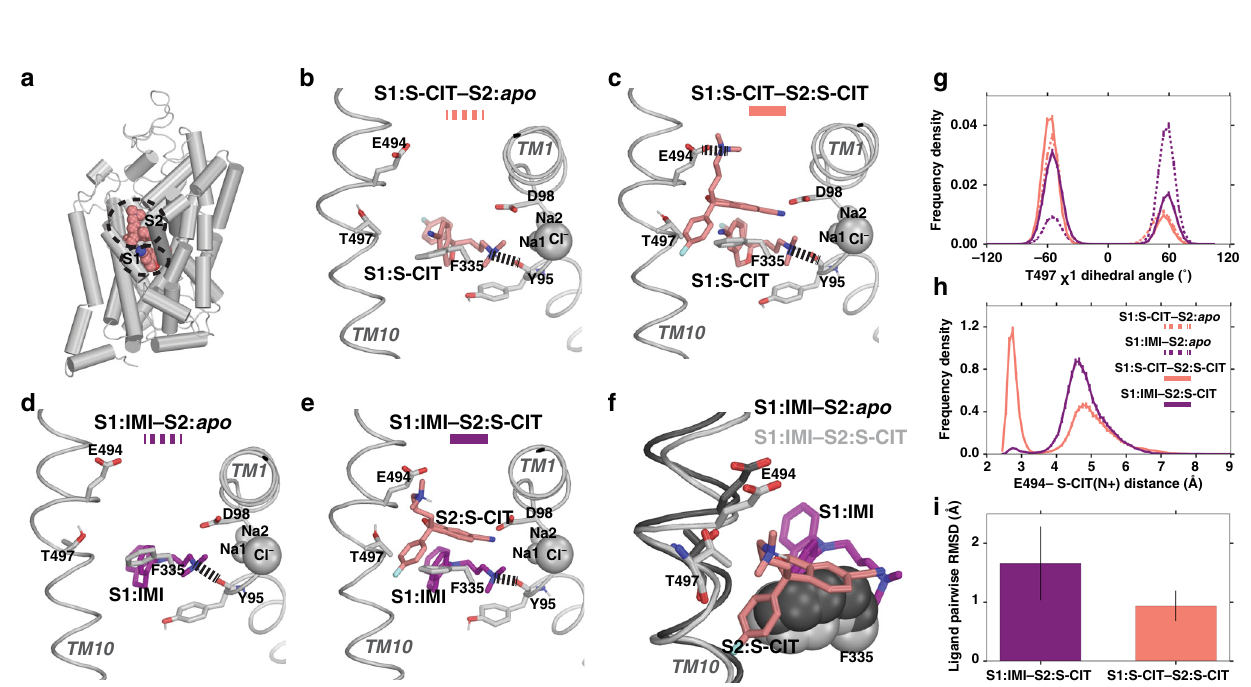
Fig. 2 MD simulations of the allosteric interaction between SERT S1 and S1 sites. In the presence of S1:S-CIT the Thr497 χ 1 dihedral is mostly shifted towards gauche − , whereas in the presence of S1:IMI, it is in gauche + , which in turn affects the salt bridge interaction between S2:S-CIT and Glu494. In all panels, the S1:S-CIT conditions are colored in salmon, whereas the S1:IMI conditions are in purple. a A zoomed-out view of the 5I73 structure showing the S1 and S2 sites. b A zoomed-in view of the equilibrated model of WT S1:S-CIT/S2: apo , c S1:S-CIT/S2:S-CIT, d S1:IMI/S2: apo , and e S1:IMI/S2:S-CIT. g Distribution of the Thr497 χ 1 rotamer for S1:S-CIT/S2: apo , S1:IMI/S2: apo (dotted lines), and S1:S-CIT/S2:S-CIT and S1:IMI/S2:S-CIT (solid lines) conditions. h Distribution of the Glu494/S2:S-CIT distance (minimum distance between the charged N of S2:S-CIT and the two carboxyl oxygens of Glu494) for S1:S-CIT/S2:S-CIT and S1:IMI/S2:S-CIT conditions. i S2:S-CIT is more stable in the presence of S1:S-CIT (salmon) than in the presence of S1: IMI (purple) measured by pairwise ligand RMSDs (see “ Methods ” ).